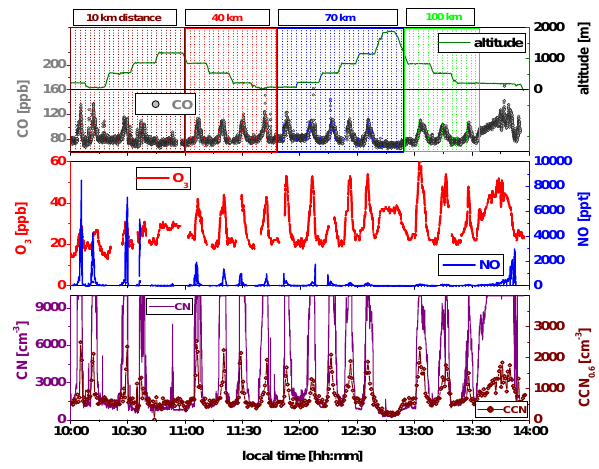
Fig. 4. Complete time series of trace constituent measurements on plume transects during Flight #18 on 19 July 10:00–14:00LT. Ver- tical profiles of crosswind transects in the urban outflow are shown for successive distances (10, 40, 70 and 100km) downwind of Man- aus City. The rightmost sections of the diagrams show the flight back to Manaus at the 200m level (crossing the plume approx. per- pendicularly). CN data were cut off at 10000cm − 3 for most of the flight; only the first transects were recorded in full scale with values up to 30000cm − 3 (data not